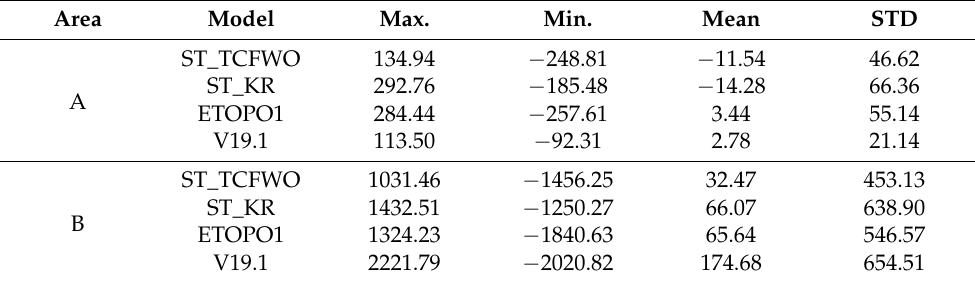
Table 8. Accuracy comparison of local models in different sea areas (unit: